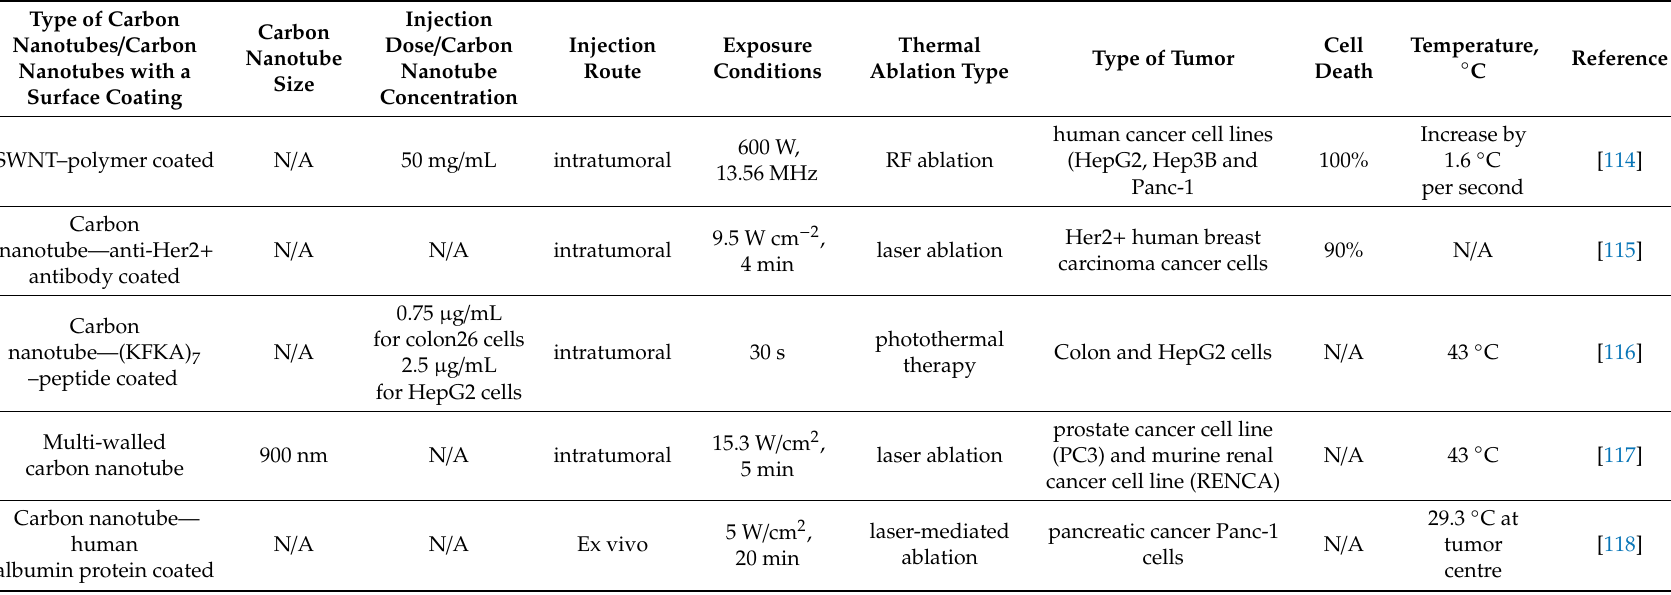
Table 5. Summary of carbon nanotubes application in the thermal ablation of